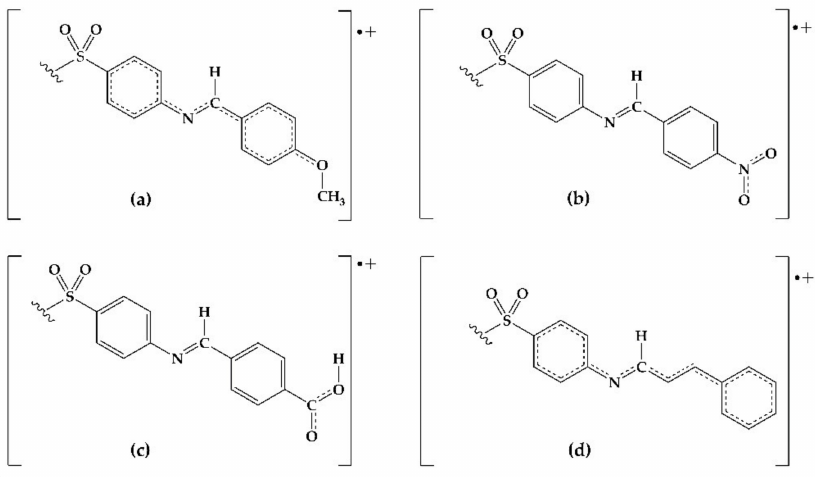
Figure 3. Possible resonant structures of derivatives ( a ) 2 , ( b ) 4 , ( c ) 9 , and ( d ) 10 .